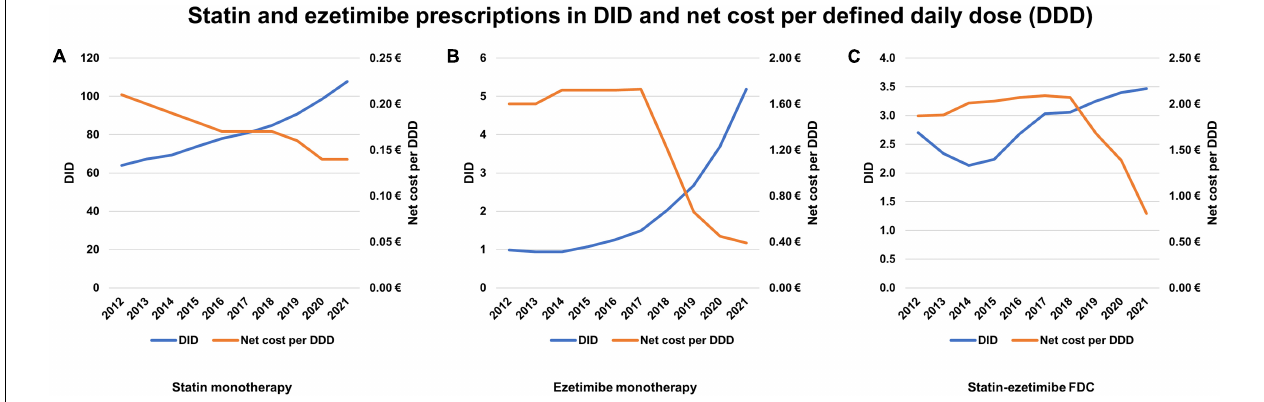
FIGURE 2 | Prescriptions of statins and ezetimibe 2012–2021 in defined daily doses per 1,000 persons insured by statutory health insurance per day (DID) and net cost per defined daily dose (DDD). (A) Statin monotherapy. (B) Ezetimibe monotherapy. (C) Statin-ezetimibe FDC. DDD, defined daily dose; FDC, fixed-dose combinations; DID, defined daily doses per 1,000 statutory health insurance-insured persons per day.